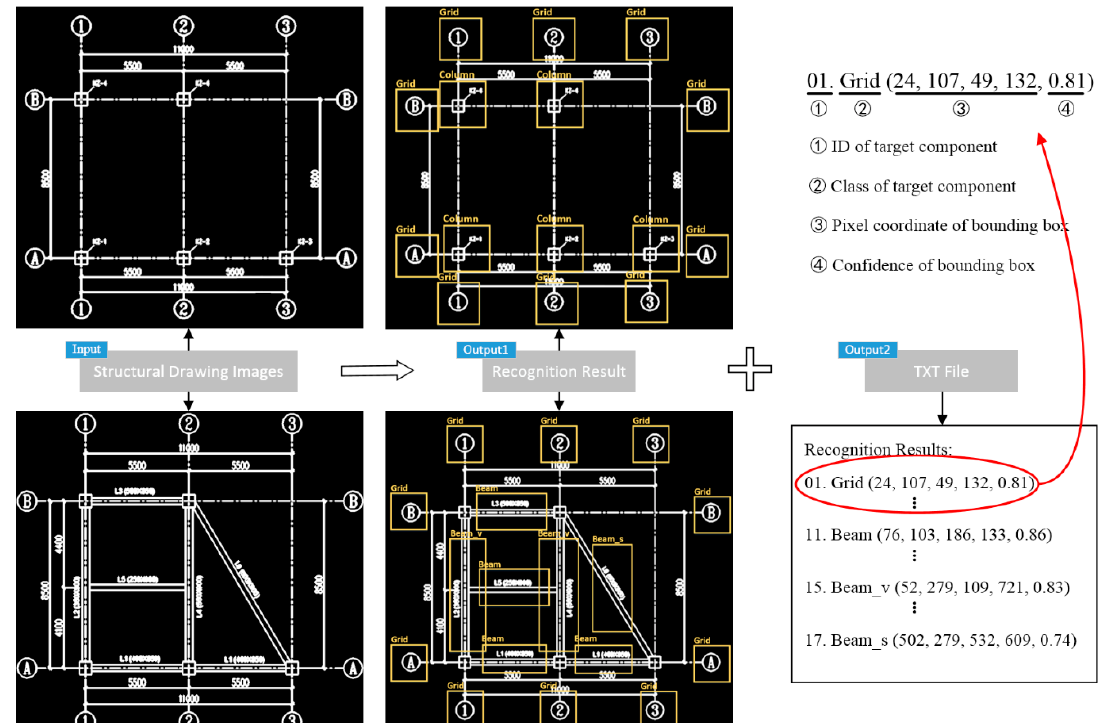
Figure 4. Example of output for component detection result.